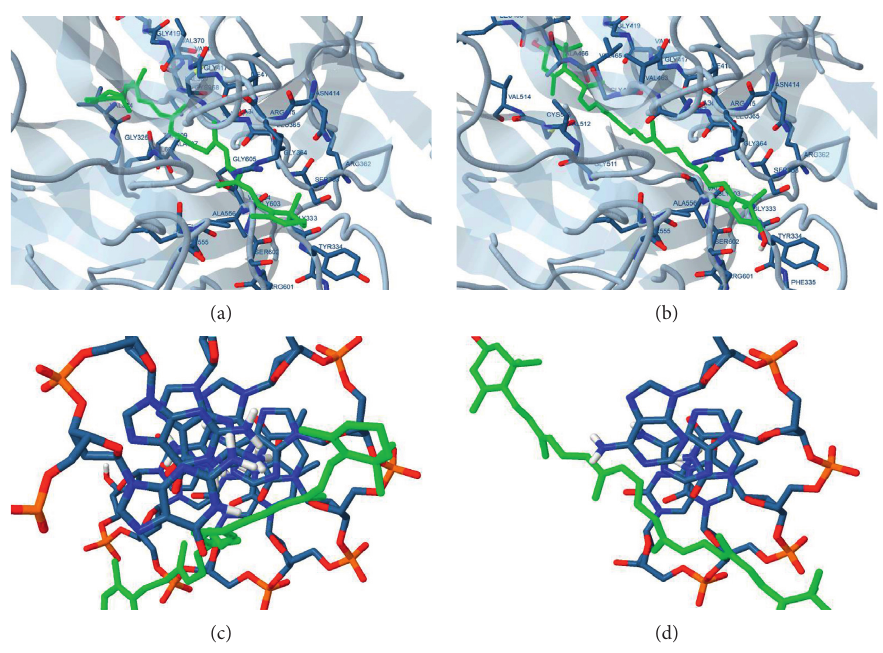
Figure 1: Docking of β -carotene and zeaxanthin on Nrf2 (a and b) and NF- κ B (c and d).